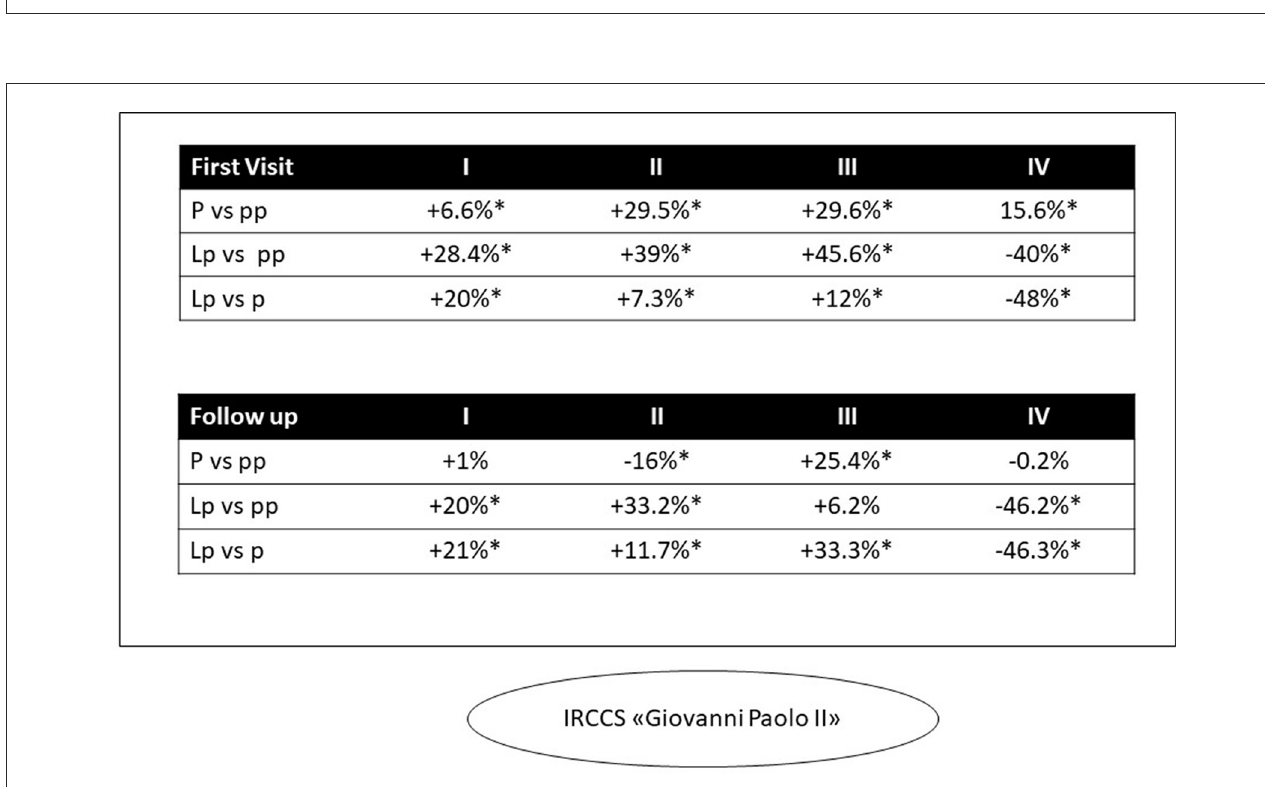
FIGURE6 Visit volume at the IRCCS Giovanni Paolo II (Bari) by quarter. * p < 0.005.